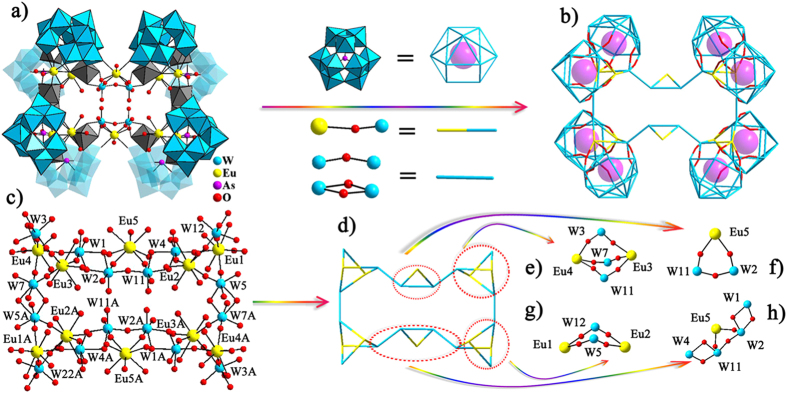
(a) The centrosymmetric polyanionic framework of
{[Eu10W16(H2O)30O50](B-α-AsW9O33)8}46−
(1a) with the size of ca.
26.3 × 29.4 Å.
(b) The simplified mode of 1a with an aesthetic skeleton.
(c) The rectangular
[Eu10W16(H2O)30O50]26+
cluster core. (d) The simplified mode of
[Eu10W16(H2O)30O50]26+
cluster core. (e) The {W3Eu2} subunit.
(f ) The bridging {W2Eu} subunit.
(g) The {W2Eu2} subunit. (h) The
interesting semilunar {W4Eu} subunit.